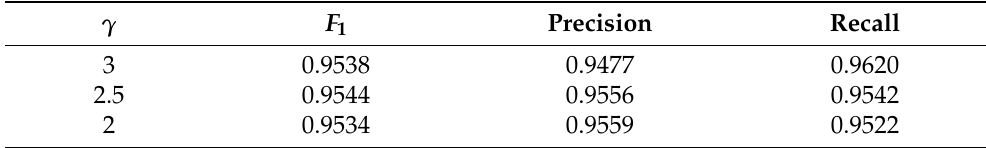
Table 2. The model’s performance on the validation set, depending on the γ value of FL with increased training length. Each of the precision and recall values was taken from the epoch with the highest F 1